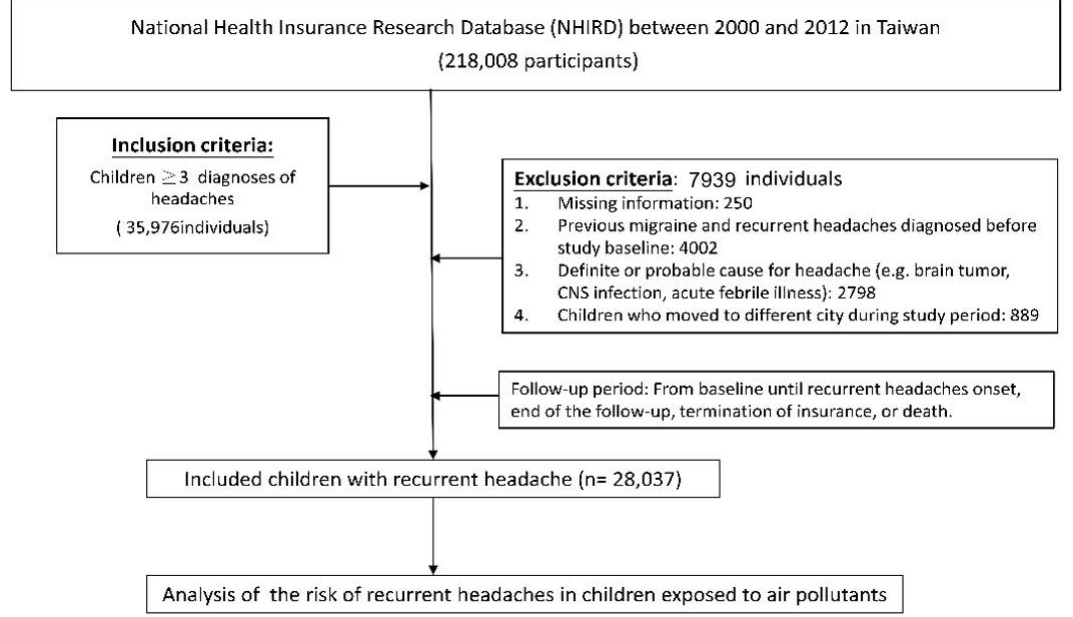
Figure 1. Flowchart of study design and study population